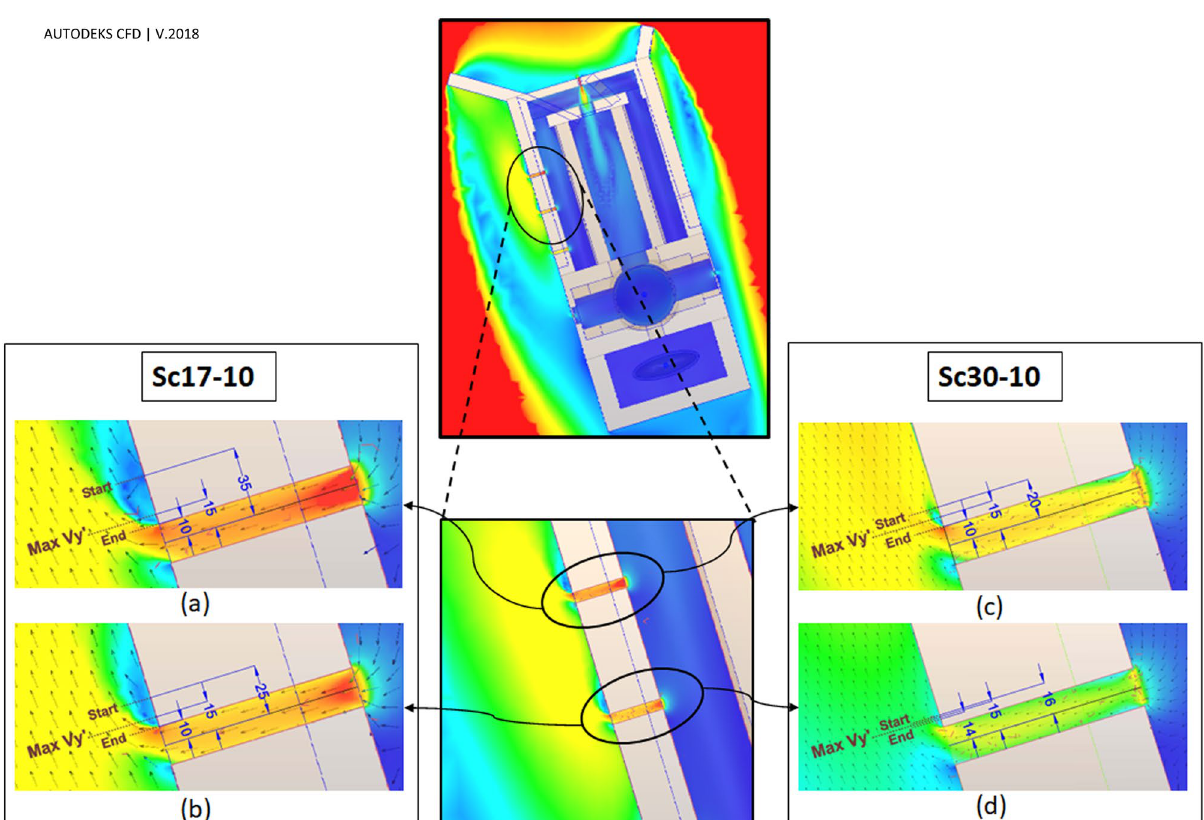
Figure 21. Eddies near ( a ) WV1 and ( b ) WV2 in Sc17-10 as well as ( c ) WV1 and ( d ) WV2 in